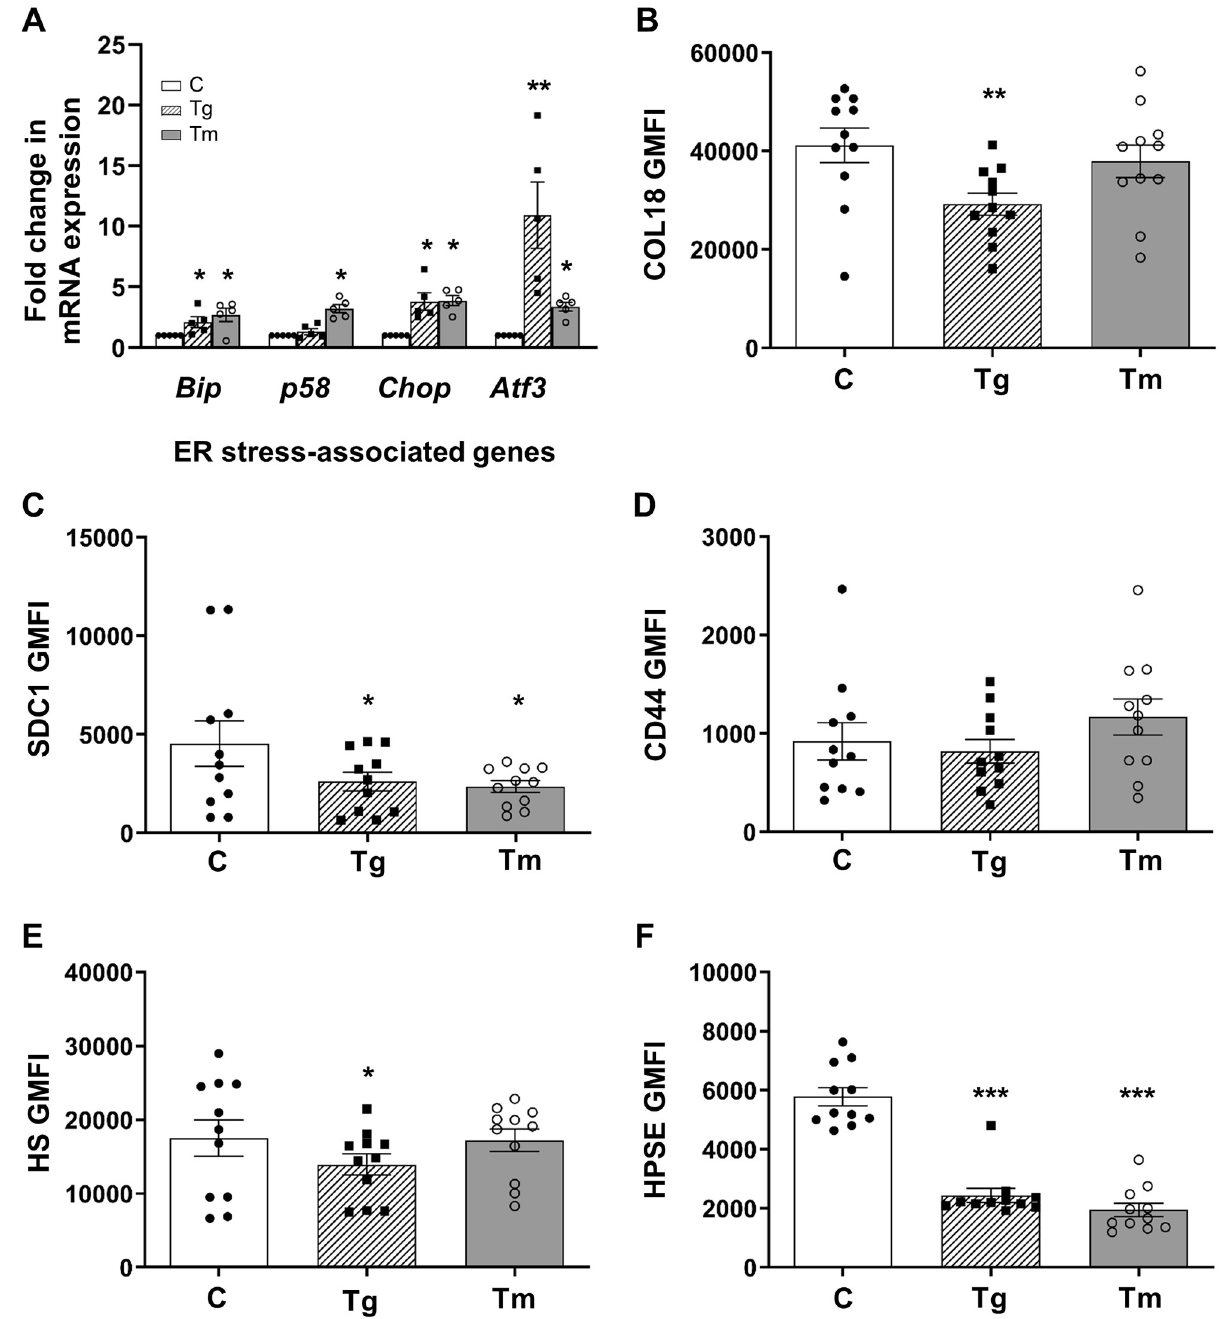
Fig 5. Intracellular levels of HSPG core proteins, HS and HPSE are decreased in ER stressed MIN6 cells. ( A ) MIN6 cells were cultured with 6 mM glucose (open bars), 50 nM thapsigargin (striped bars) or 2 μ M tunicamycin (grey bars) for 20–24 hours. Transcript levels for Bip , p58 , Chop and Atf3 were normalized to the house-keeping gene Ube2d1 and were quantified as a fold change compared to 6 mM control mRNA levels which were assigned a value of 1. ( B-F ) MIN6 cells were cultured for 3 days with 6 mM glucose-DMEM (control cells, C), 50 nM thapsigargin (Tg) or 2 μ M tunicamycin (Tm) and intracellular HSPG core protein ( B ) COL18, ( C ) SDC1 and ( D ) CD44, ( E ) HS and ( F ) HPSE levels were assessed by flow cytometry and expressed as GMFI. Data represent mean ± SEM for ( A ) n = 5 independent experiments and ( B-F ) n = 11 experiments. � p < 0.05, �� p < 0.01 and ��� p < 0.001, One-way ANOVA with Fischer’s unprotected LSD test.